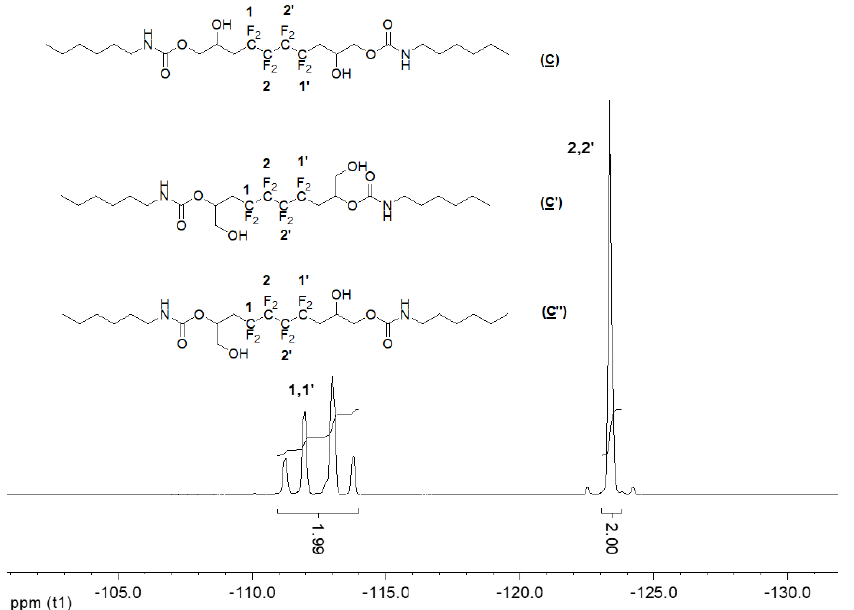
Figure 5. 1 H NMR spectrum of the model hydroxyurethanes ( C ), ( C′ ), and ( C″ ) (DMSO-d6, 20 °C, 400 MHz) .